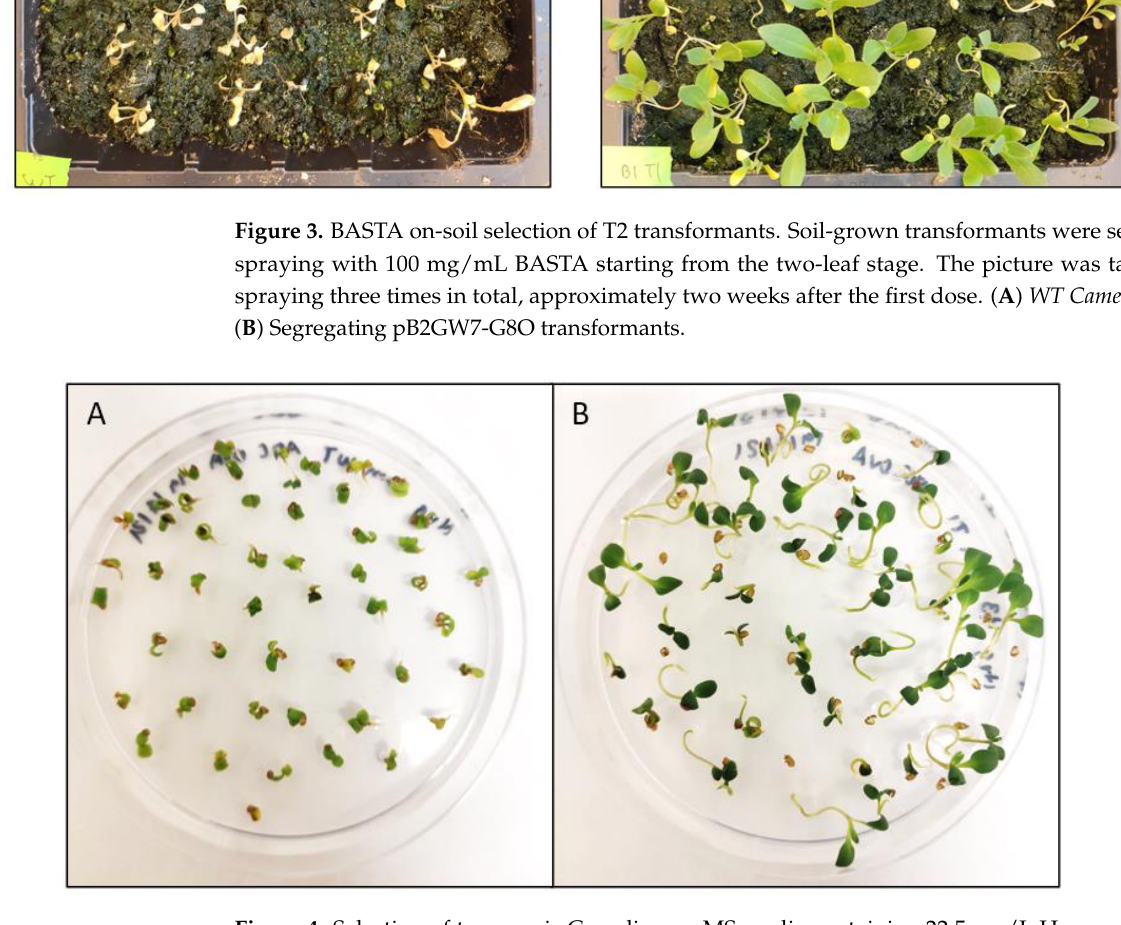
Figure 5. Selection of transgenic Camelina on MS media containing 15 mg/L of BASTA. Pictures taken after 14 days. ( A ) WT Camelina sativa ( B ) Segregating T2 generation of pB2GW7 transformants (BASTA-resistant). Consequently, we tested the effect of both antibiotics at the doses we found to be effective for Camelina: Hyg 22.5 mg/L and BASTA 15 mg/L. WT Camelina, Hyg-resistant and BASTA-resistant plants were grown in Petri dishes with no antibiotics, Hyg 22.5 mg/L or BASTA 15 mg/L. After 14 days of growth, various parameters such as leaf area and shoot length were measured (Figure 6). Overall, it was observed that all the seeds germi- nated under all conditions, and they developed true leaves, except for WT Camelina grown in either of the antibiotics. For both leaf area and shoot length, only WT Camelina exposed to BASTA and Hygromycin showed significantly reduced growth when com- pared with WT Camelina growing without antibiotics. The selected concentrations of an- tibiotic thus allowed plants containing the resistance genes to grow healthily, while wild type plants were effectively selected against.